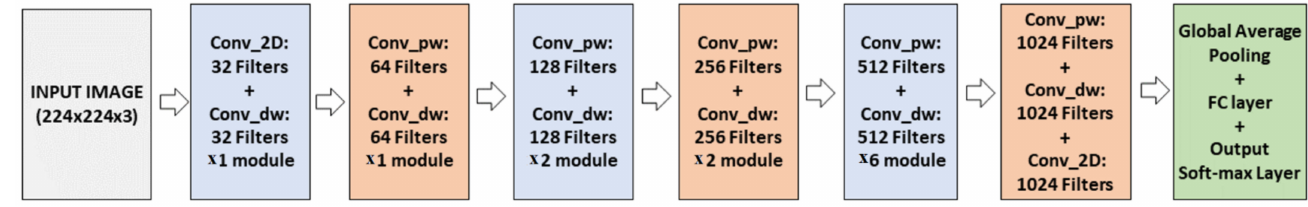
Figure 3. Structure of